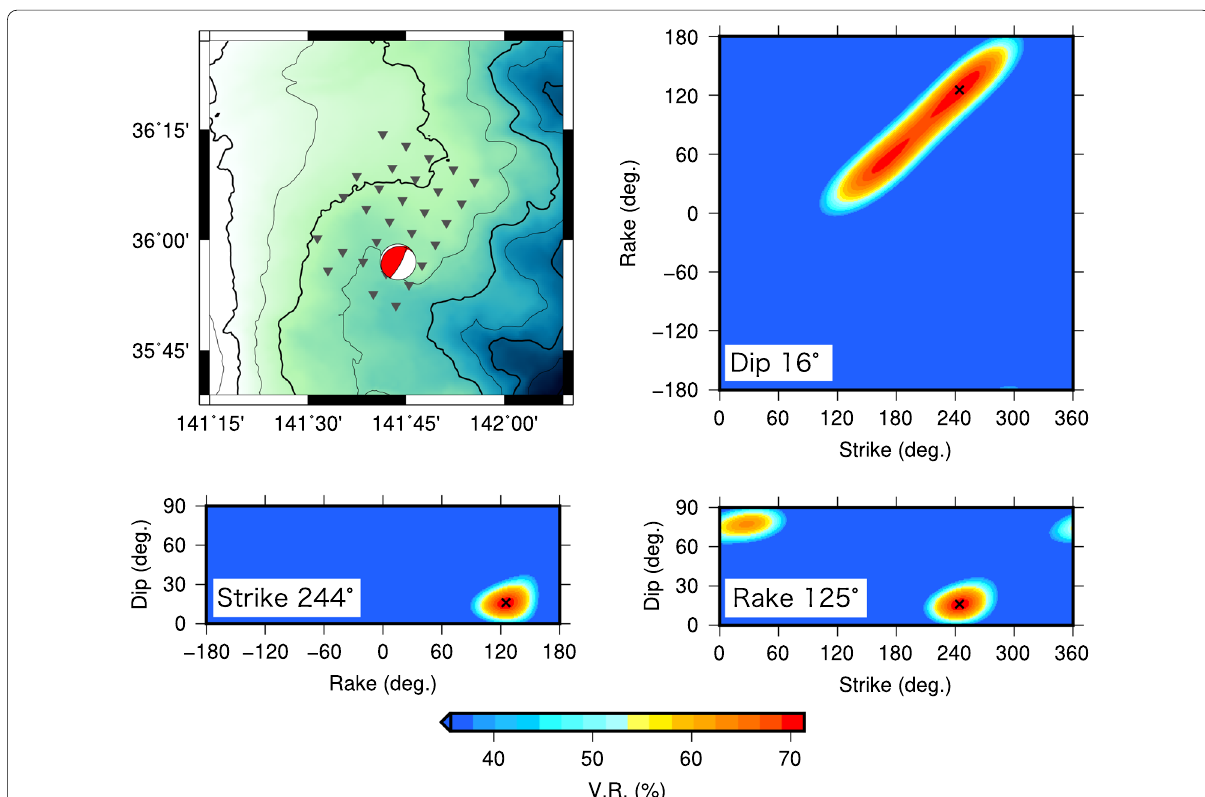
Fig. 5 Distribution of the VRs for the earthquake ( M w = 3.8 ) that occurred at 14:36, March 12, 2011 (JST), shown in the left top panel. Synthetic seismograms were calculated assuming double-couple sources, and fixing centroids and seismic moments. The strike, dip, and rake for the cross sections are the thrust fault of the obtained CMT